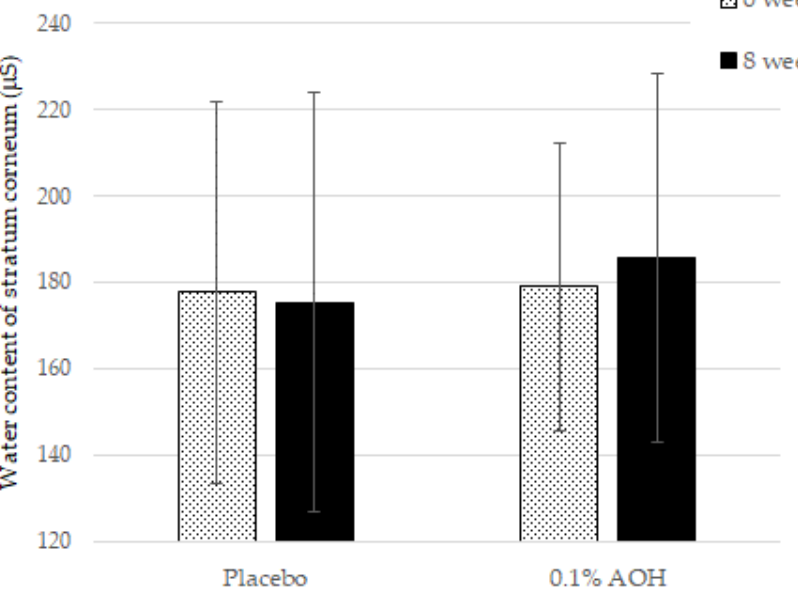
Figure 2. Water content of stratum corneum at the beginning of the study and after eight weeks.